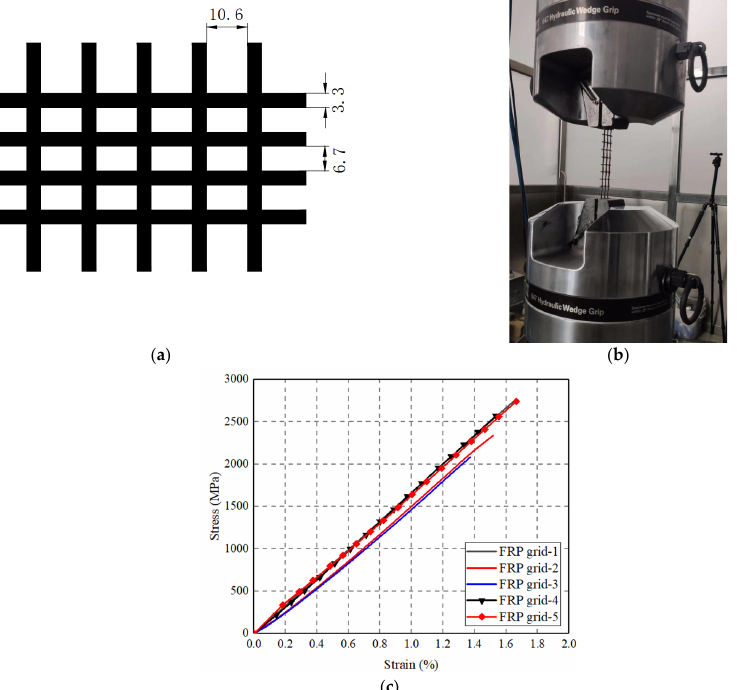
Figure 6. FRP grid coupons. ( a ) Dimension of FRP grid (unit: mm); ( b ) Tensile test set-up; ( c ) Stress– strain curves of FRP grid coupons.